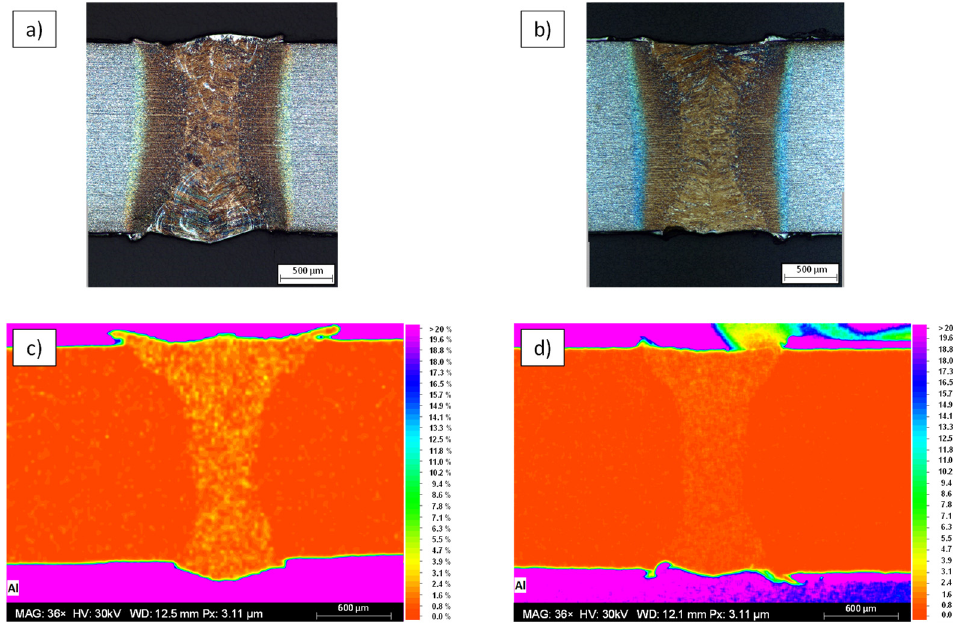
Figure 6. Light microscopy images depicting etched cross ‐ sections of the weld obtained without ( a ) and with ( b ) ultrasonic excitation. ( c , d ) illustrate the corresponding EDS-maps for aluminum.